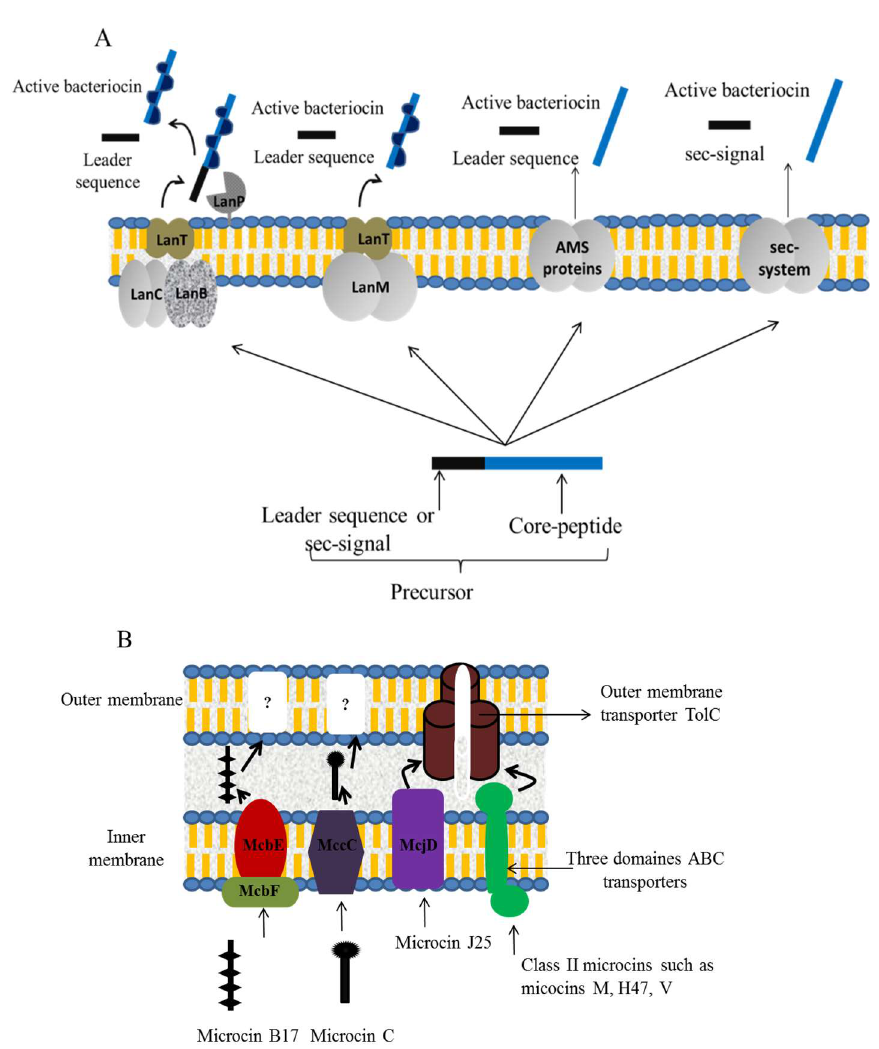
Figure 3. Transport mechanisms involved in the export of BGPB ( A ) and BPGN ( B ) from the producer strain.